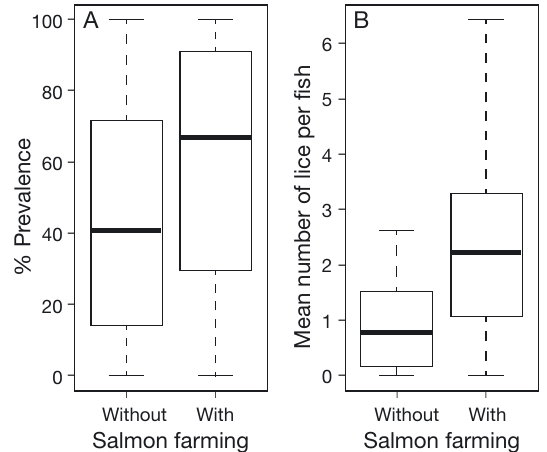
Fig. 2. (A) Prevalence and (B) mean number of salmon lice per sea trout sampled in areas where salmon farming was present (‘with’) and not present (‘without’). Box plots show the median (line) and interquartile range (box length, IQR), whiskers extend to 1.5 × IQR. Data sourced from published studies: Boxshall (1974), Tully et al. (1993a,b, 1999), Sharp et al. (1994), Birkeland (1996), Birkeland & Jakobsen (1997), Tingley et al. (1997), MacKenzie et al. (1998), Mo & Heuch (1998), Bjørn & Finstad (2002), Marshall (2003), Rikardsen (2004), Bjørn et al. (2007, 2011), Urquhart et al. (2008, 2010), Serra Llinares et al. (2014), Vollset & Barlaup (2014). Mean numbers of lice are